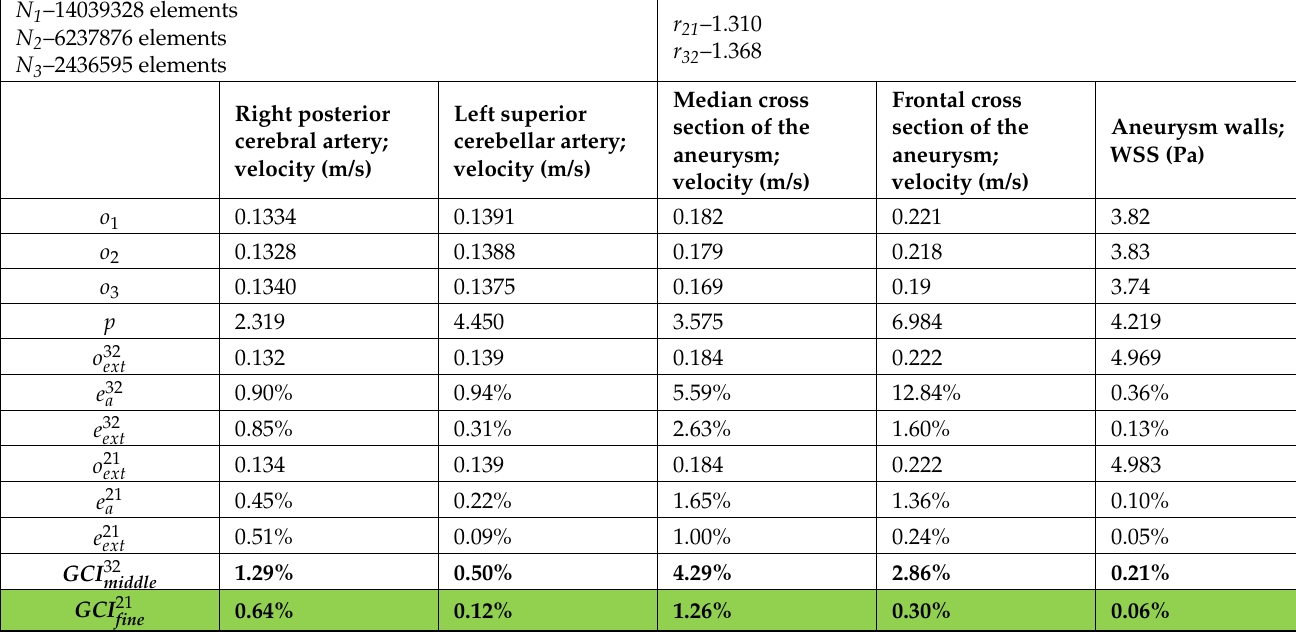
Table 2. Mesh independence test for the analyzed